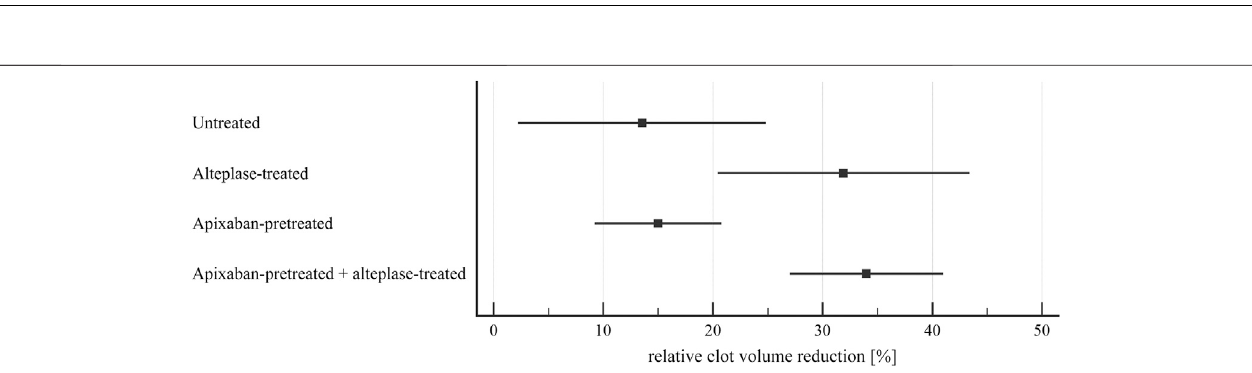
Frontiers in Pharmacology |